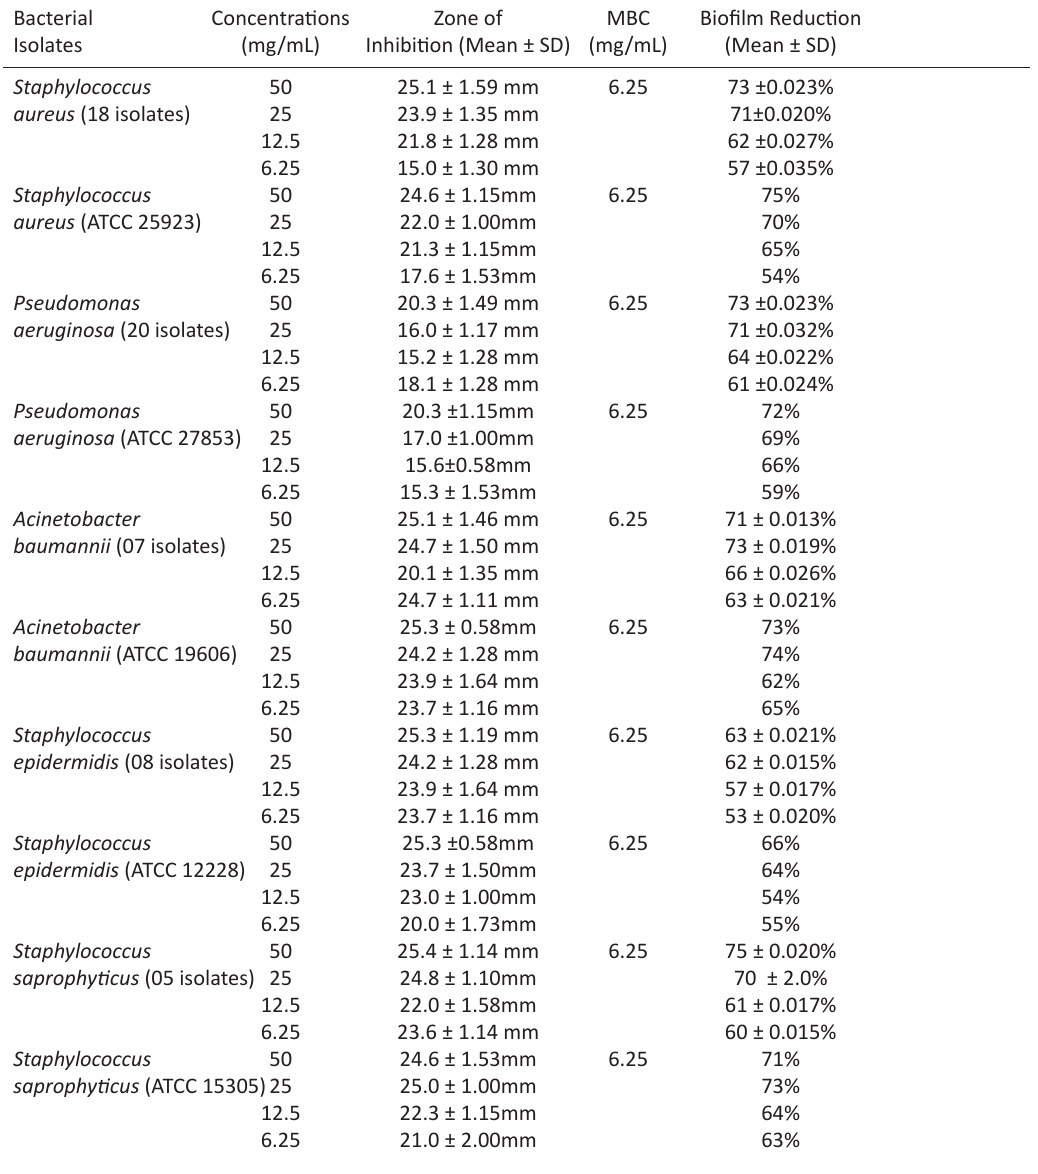
Table 3. Antibacterial and antibiofilm activity of Camellia sinensis Bacterial Concentrations Zone of